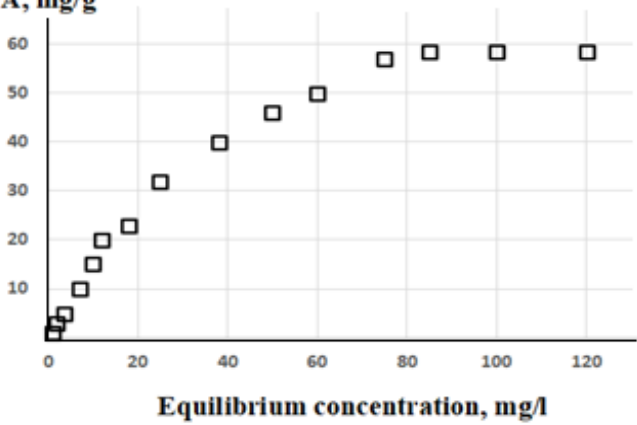
Figure 6. Effect of solution pH on the efficiency of copper cations sorption by GO-Ch sorbent No. 4. Isotherm of copper cation [44] sorption was constructed for sample No. 4 (Figure 7).